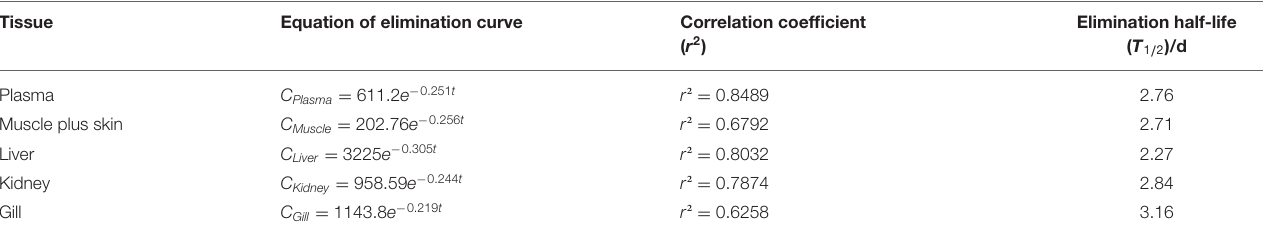
TABLE 4A | The equation of elimination curve, correlation coefficient ( r 2 ) and elimination half-life ( T 1 / 2 ) of Nile tilapia after daily oral administration of a single dose of 20 mg/kg for 5 days at 19 ◦ C. Tissue